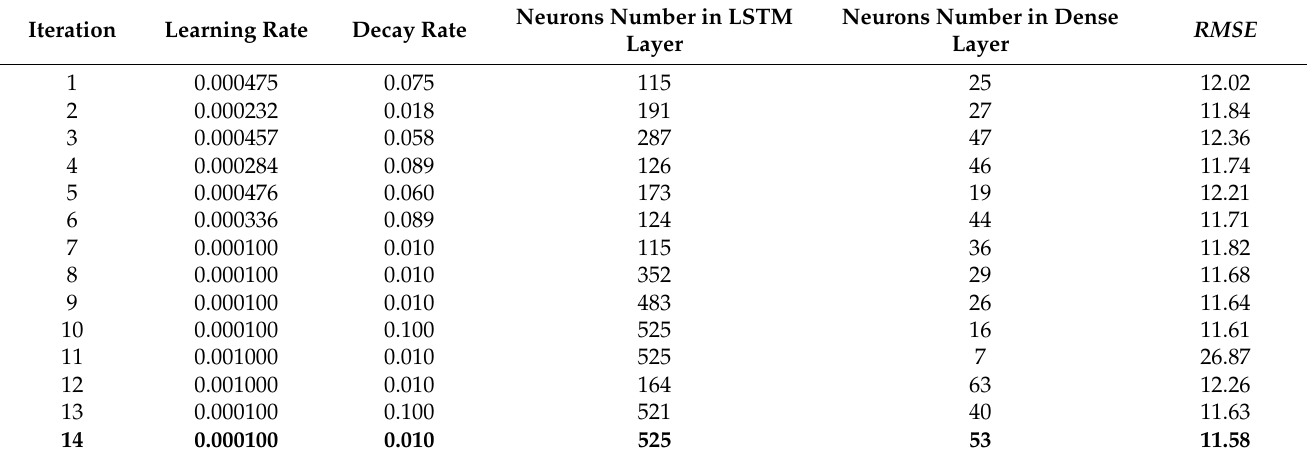
Table 4. Hyperparameter searching